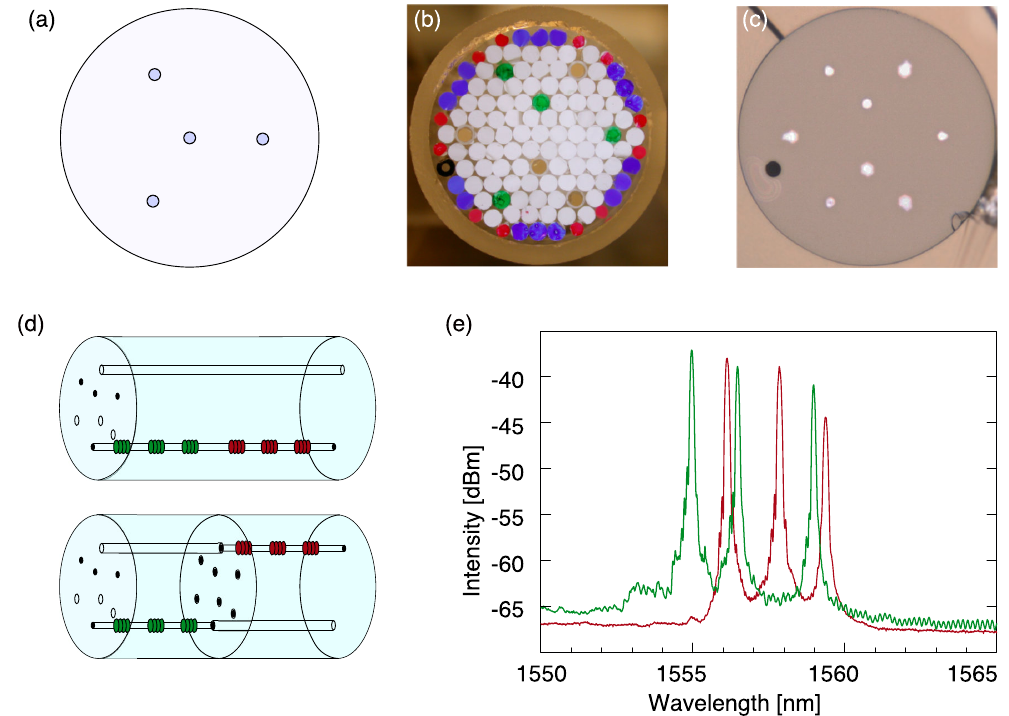
Figure 5. Experimental proof-of-concept of the multiplexing fiber component. ( a ) Cross-section of a typical shape sensing fiber. ( b ) Stacked preform for the multiplexing fiber element with photosensitive sub-preforms marked green, insensitive sub-preforms in dark-beige, filling rods of two different size are marked with violet and red. ( c ) Microscope image of the drawn fiber, larger diameter circles correspond to the cores insensitive to UV illumination, small diameter circles represent the photosensitive cores. A small capillary (black) was introduced in the preform for assuring the required orientation. ( d ) Fiber component is prepared by splicing two pieces with a rotational shift of 180 ◦ . ( e ) Spectra of FBGs in two cores out of eight (green spectrum corresponds to the FBGs depicted in green in ( d ), and red spectrum correspond to the FBGs depicted in red in ( d